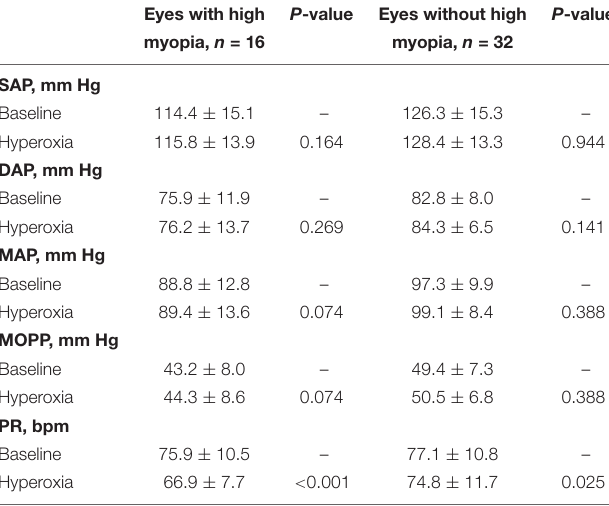
Data are expressed as mean ± standard deviation. SAP, systolic arterial pressure; DAP, diastolic arterial pressure; MAP, mean arterial pressure; MOPP, mean ocular perfusion pressure; PR, pulse rate.